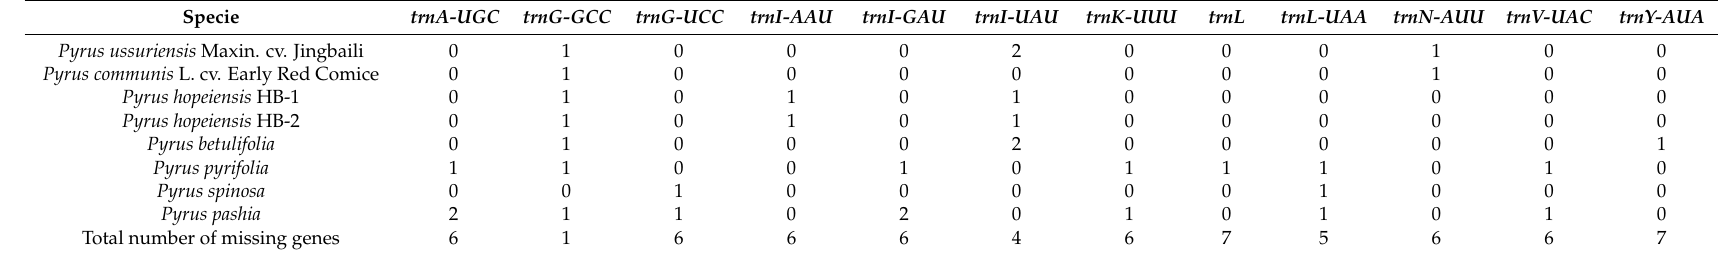
Table 5. Genes from the chloroplast genomes of Pyrus